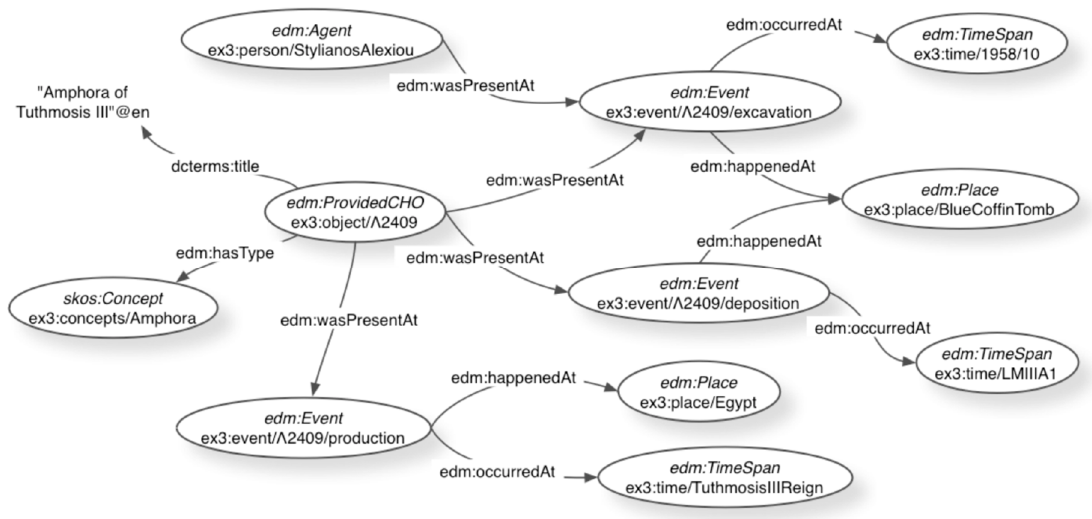
Figure 2. Example of metadata record using the Europeana Data Model, illustrated as a RDF graph.